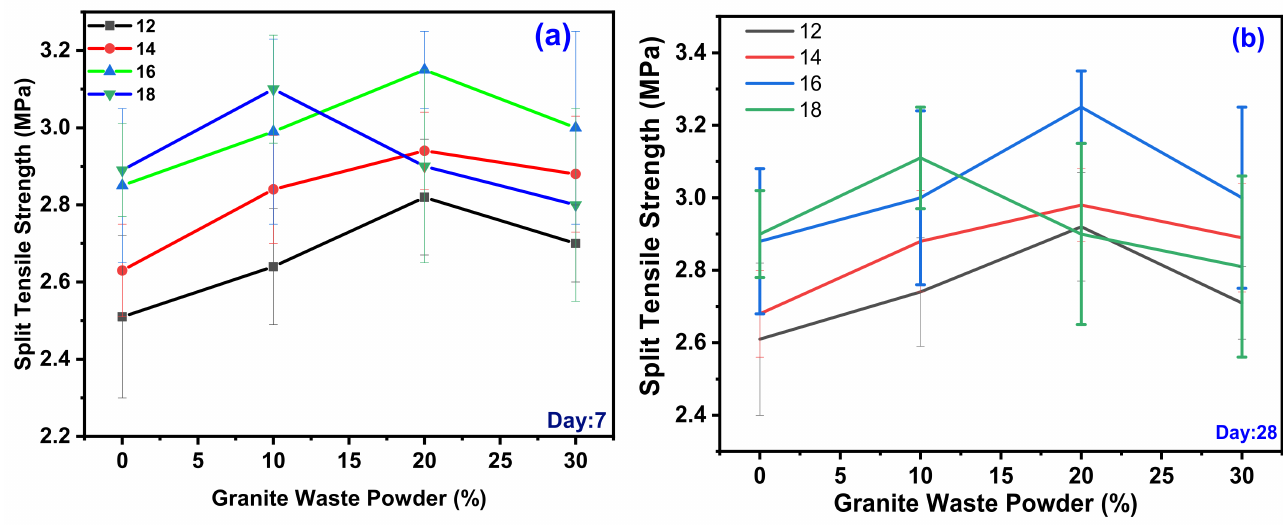
Figure 3. Variation of GWP on the different molarity for STS days 7 ( a ) and 28 ( b ).